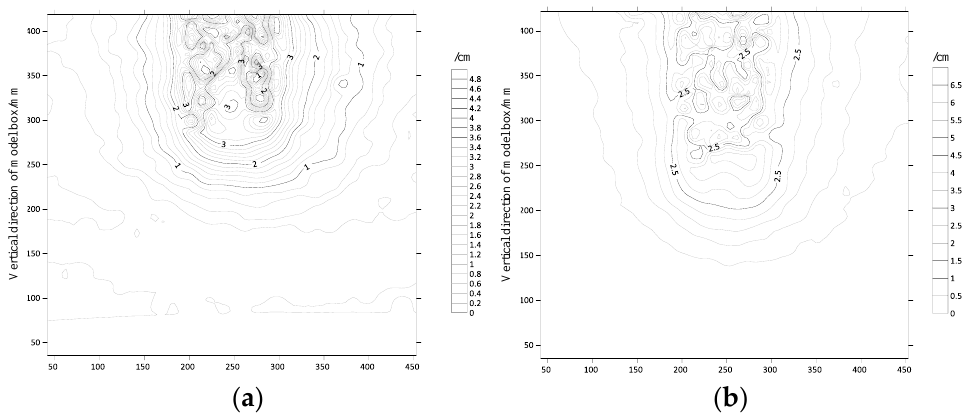
Figure 15. Soil body displacement contour diagram for different penetration of piles at the ( a ) pile penetration of 100 mm, and ( b ) pile penetration of 150 mm.